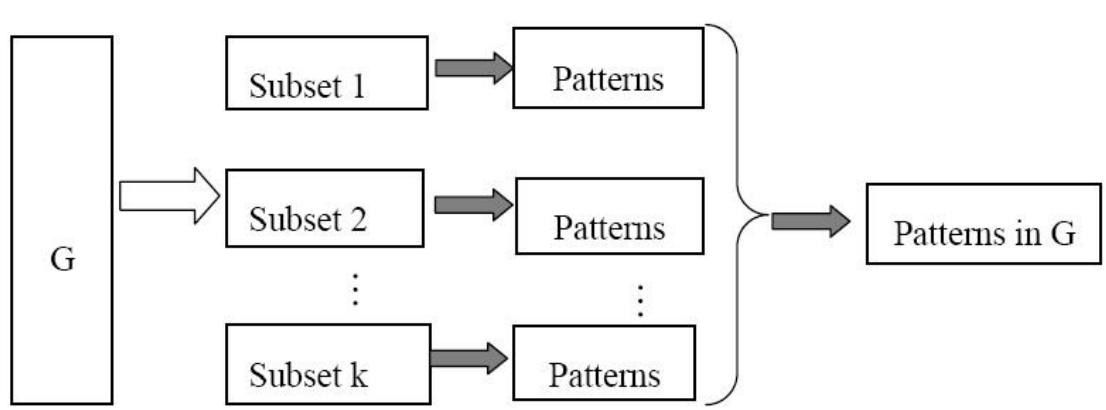
Figure 2: Handling large dataset by divide and conquer. The gray arrows show when the DDP algorithm is carried